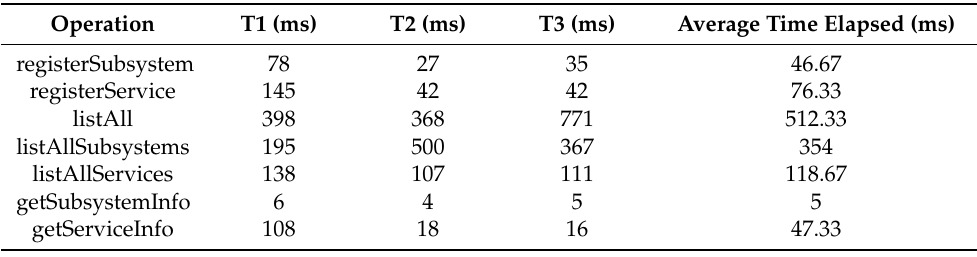
Table 6. Response time when there are 1000 subsystems and services